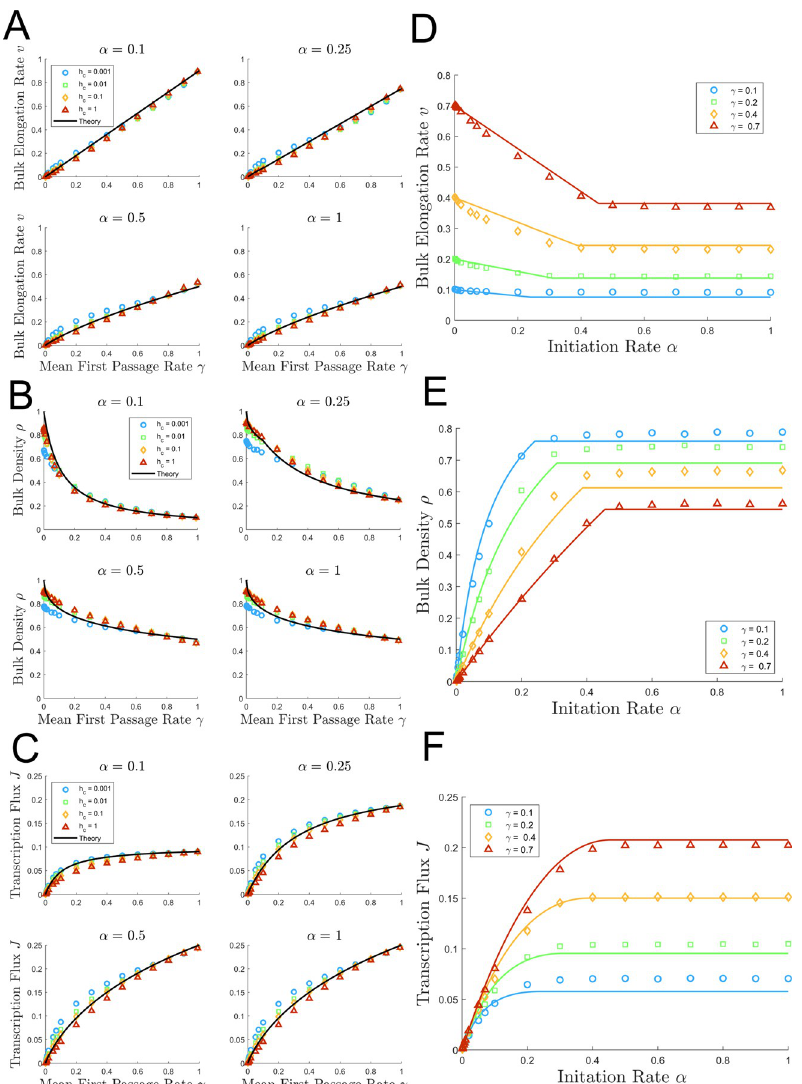
Fig 5. Dependence of the elongation rate v, polymerase density ρ , and transcription flux J on the initiation rate α and the mean first passage rate γ . The left panels A, B and C show the dependence of v (Eq 38), ρ (Eq 39), and J (Eq 40) on γ . γ is varied from 0.001 to 0.99 by adjusting h for fixed values of h equal to 0.001 (blue), 0.01 (green), 0.1 o c (orange), and 1 (red). For each subpanel of A, B, and C, a different α values is assumed: 0.1 (top left), 0.25 (top right), 0.5 (bottom left), 1 (bottom right). The right panels D, E and F show the dependence of v (Eq 38), ρ (Eq 39), and J (Eq 40) on α . α is varied from 0.001 to 1 for fixed values of γ equal to 0.1 (blue), 0.2 (green), 0.4 (orange), and 0.7 (red) under the constraint that h = h . Data points represent the average simulation results from 50 simulations with 2 × 10 6 o c Monte Carlo steps each, and solid lines represent theoretical estimates.